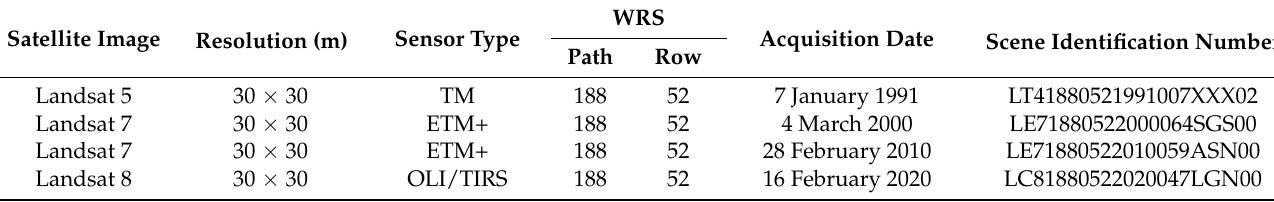
Table 2. Sources and description of satellite